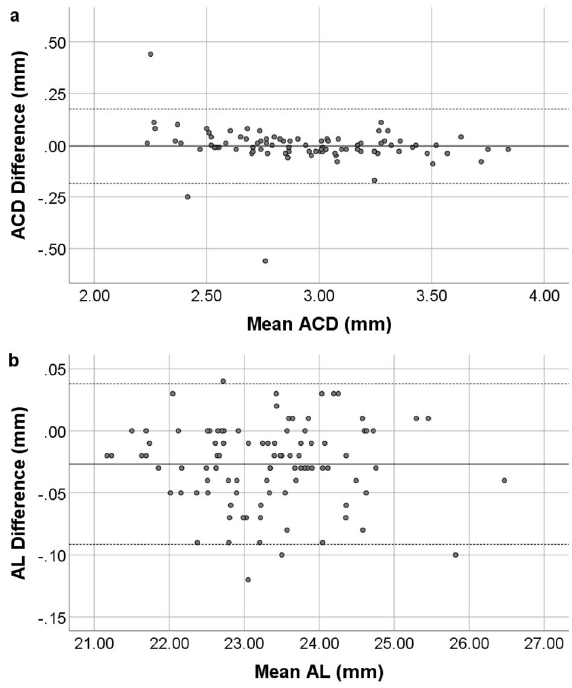
Figure 1. Bland–Altman plot of the ACD ( a ) and AL ( b ) from GALILEI G6 and ANTERION. The solid line represents the mean difference, whereas the dotted lines on each side show the upper and lower 95% LoA. The ACD and AL plot demonstrate that only three and four eyes respectively of the total of 96 eyes were out of the 95% LoAs, indicating excellent agreement in ACD and AL between the two devices. Created by SPSS (Version 22, SPSS Inc., IBM, Chicago,